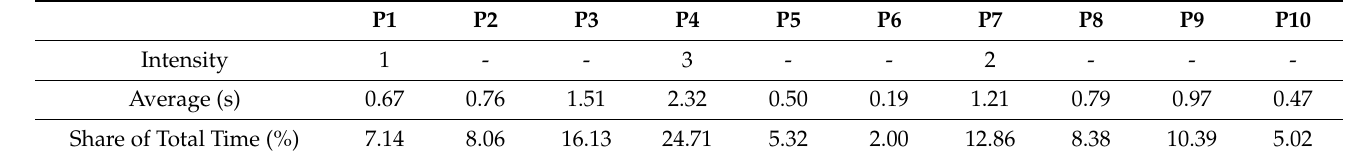
Table 6. Fixation times in the product category with animations. Source: own